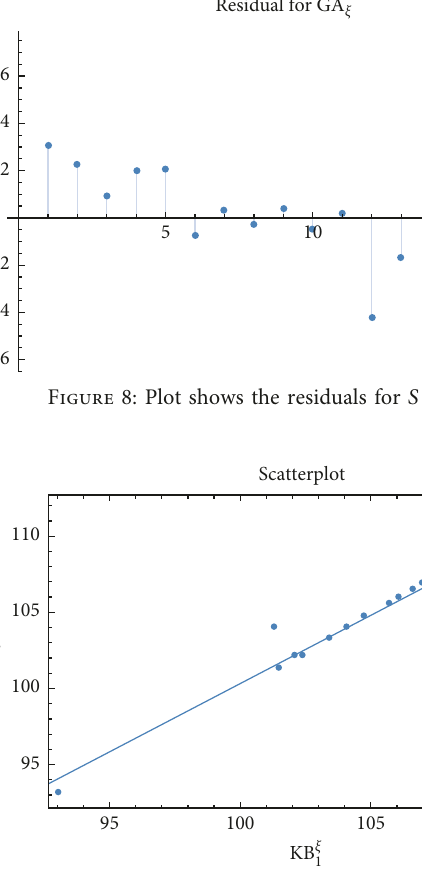
Figure 9: Scatter diagram of S on KB ξ regression line. . ξ